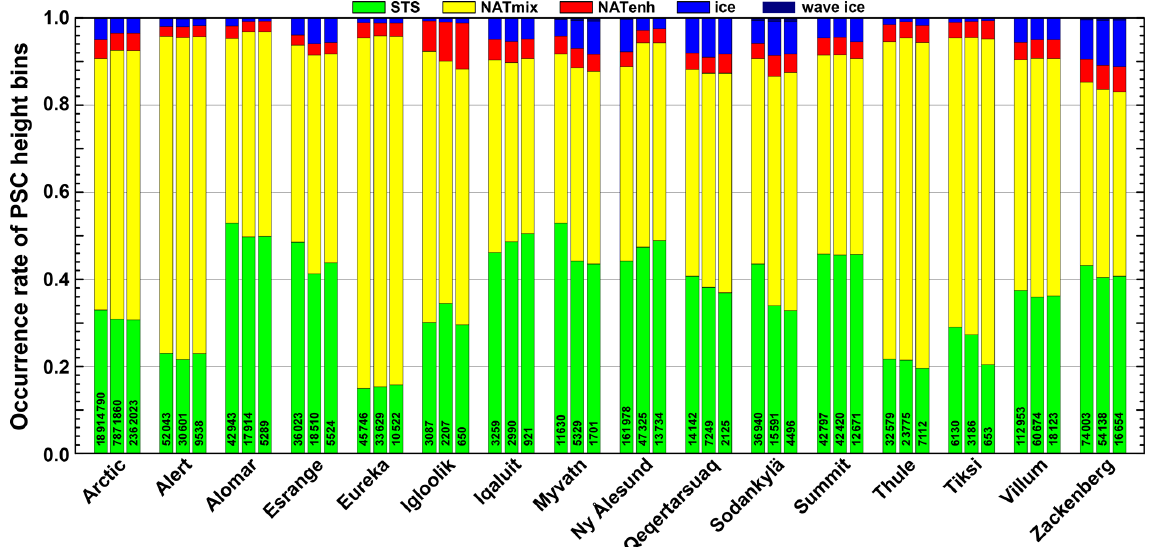
Figure 4. Occurrence rate of STS (green), NAT mixtures (yellow), NAT enhanced (red), ice (blue), and wave ice (dark blue) for the entire Arctic as well as for the Arctic ground stations listed in Table 1. The three bars per site refer to (i) all-sky conditions in the troposphere (the view of a spaceborne lidar, left, not possible with ground-based instruments), (ii) conditions with no tropospheric clouds or transparent clouds only (the view of a ground-based lidar with CALIPSO-synchronous measurement protocol operated during every single CALIPSO overpass, middle), and (iii) one-third of randomly selected profiles from observations with no tropospheric clouds or transparent clouds only (the view of a CALIPSO-synchronously operated ground-based instrument that is affected by cloudiness and other measurement-inhibiting factors, right). Numbers refer to the total number of considered PSC height bins per